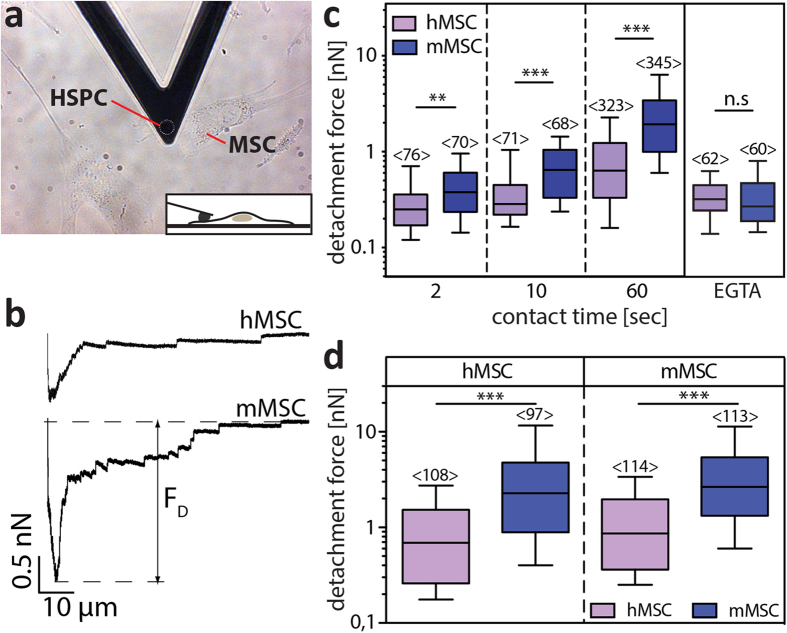
The adhesion forces of human HSPCs on murine or human MSCs are measured by AFM.(a) Phase contrast image of a human (h) HSPC attached to a tipless AFM cantilever. MSCs growing on fibronectin-coated coverslips are visible (see Supplementary Fig. S1). The inset illustrates a side-view of the contact between a single hHSPC and a MSC. (b) Representative retract F-D curves of an adhesion measurement between hHSPC and h (top panel) or murine (m, bottom panel) MSC are depicted. The contact time was 60 sec. The minimum of the curves (with respect to the zero force level) is the maximum detachment force (FD) needed to separate both cells. (c) Box-whisker plots show FD of freshly isolated CD34+ hHSPC measured from h (purple bars) or m (blue bars) MSC after a contact time of 2, 10 or 60 sec in absence or presence of 5 mM EGTA (EGTA, 60 sec contact time). (d) Box-whisker plots show FD of CD34+ HSPCs pre-cultured for seven days either on h (left panel) or m (right panel) MSCs prior to force measurements on h (purple bars) or m (blue bars) MSC with a contact time of 60 sec. Box-whisker plots represent half of the data points within the box and 80% within the whiskers. Horizontal lines within the box represent median values. Numbers within bars (<n>) show the total number of analyzed FD curves. Four experiments were performed for each condition using CD34+ hHSPCs isolated from different donors. MSCs were derived from one donor or one murine cell preparation, but additional data with other donors/cell preparations are presented in Supplementary Fig. S6. The pairwise comparison of data was performed using Mann-Whitney-U-test (**p < 0.01; ***p < 0.001; n.s., not significant, ≥0.05).